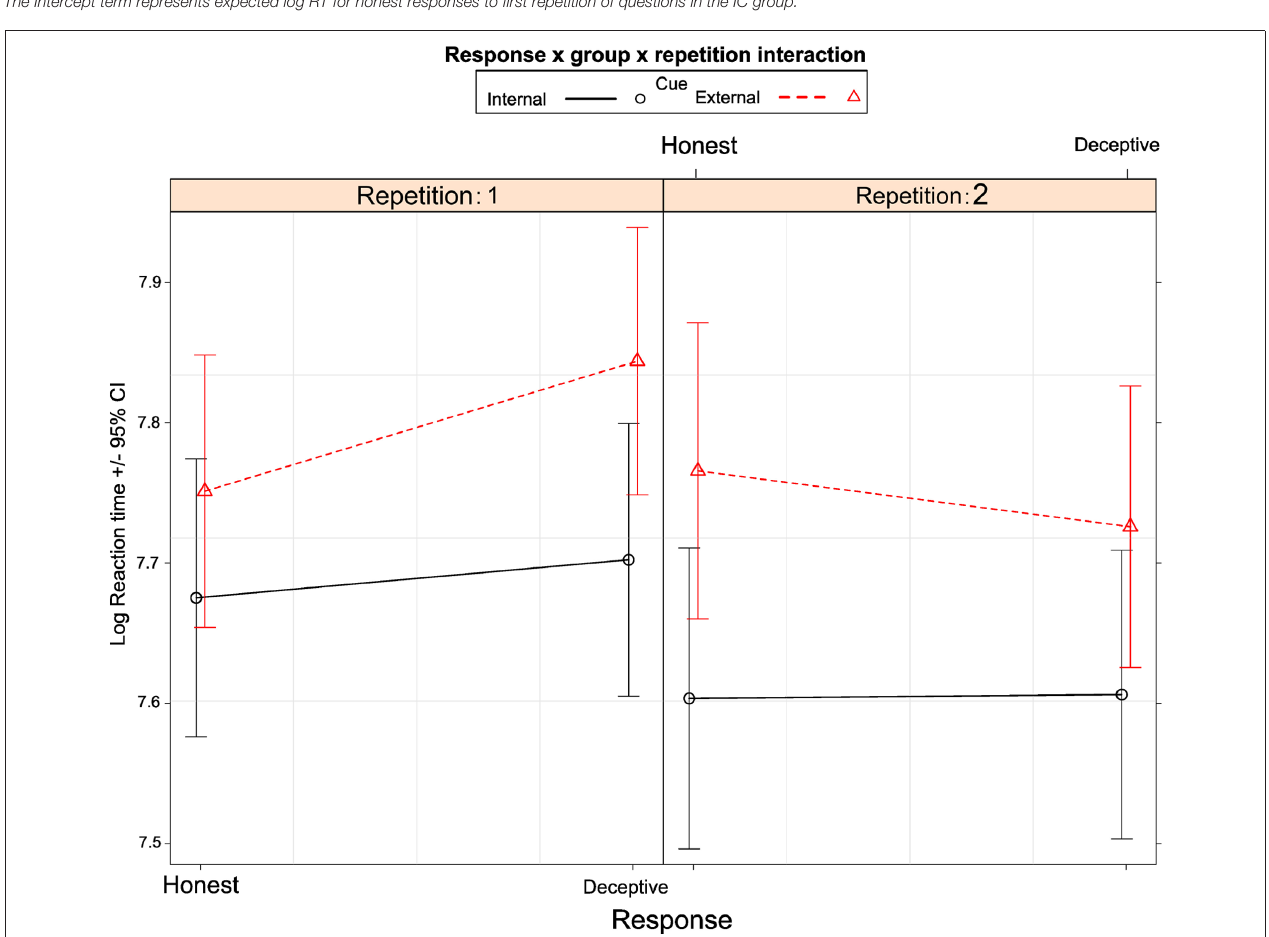
FIGURE 3 | Least-squares estimates of expected RT values with 95% confidence intervals for all conditions.